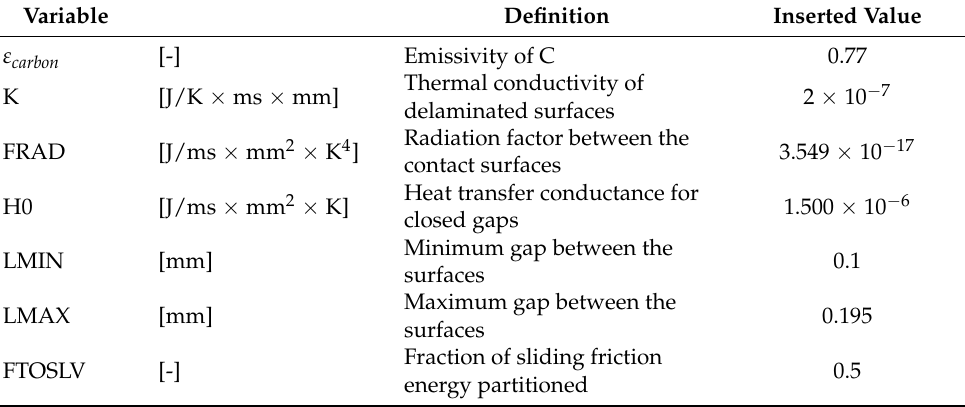
Table 11. Thermal parameters for the internal contact algorithm characteristic of F3900, as published in [34,36], based on Equations (8)–(10).